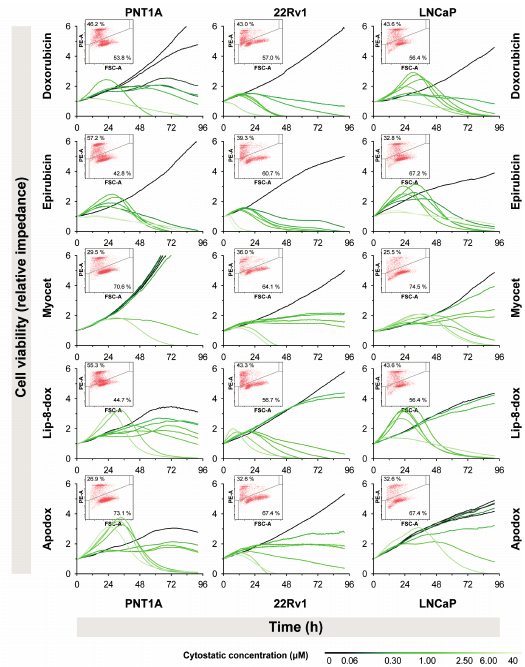
Figure 3. Analysis of prostatic cell line growth treated with modified forms of doxorubicin using RTCA xCELLigence and determination of viable cell numbers by propidium iodide exclusion (inset). Cell lines shown in columns, modified doxorubicin forms in rows. Cell growth expressed as “cell index” on y -axis is based on impedance measurement. Increasing concentrations of antineoplastic agents in range 0–40 µM are depicted by green color gradient. Inset: viable cell numbers analyzed after treatment with IC 50 concentrations of individual cytostatics on individual cell lines as determined by RTCA. FSC-A, forward scatter. Grey line indicate gating threshold for propidium iodide (PI)-positive (upper–left) and -negative cells (lower–right). Percentages in subsequent gating regions indicate number of PI-positive and -negative